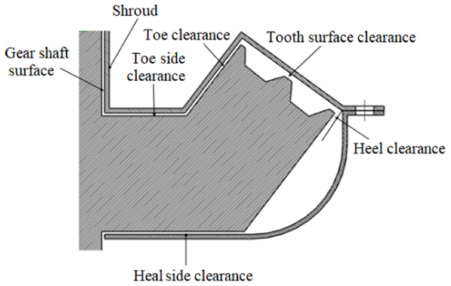
Figure 14. Sectional view of gear with